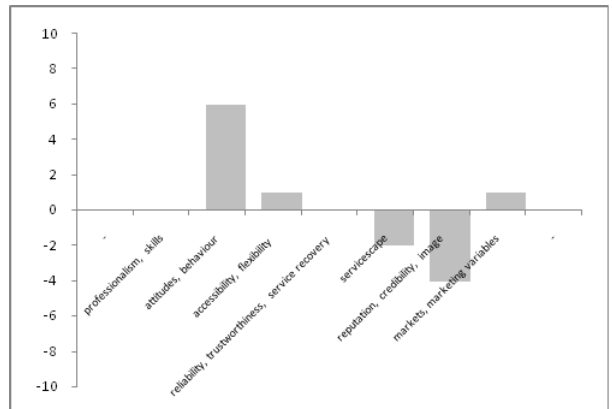
Figure 9: The underlying drivers of consumption in Factor 6 Table 9: Participants loading on Factor